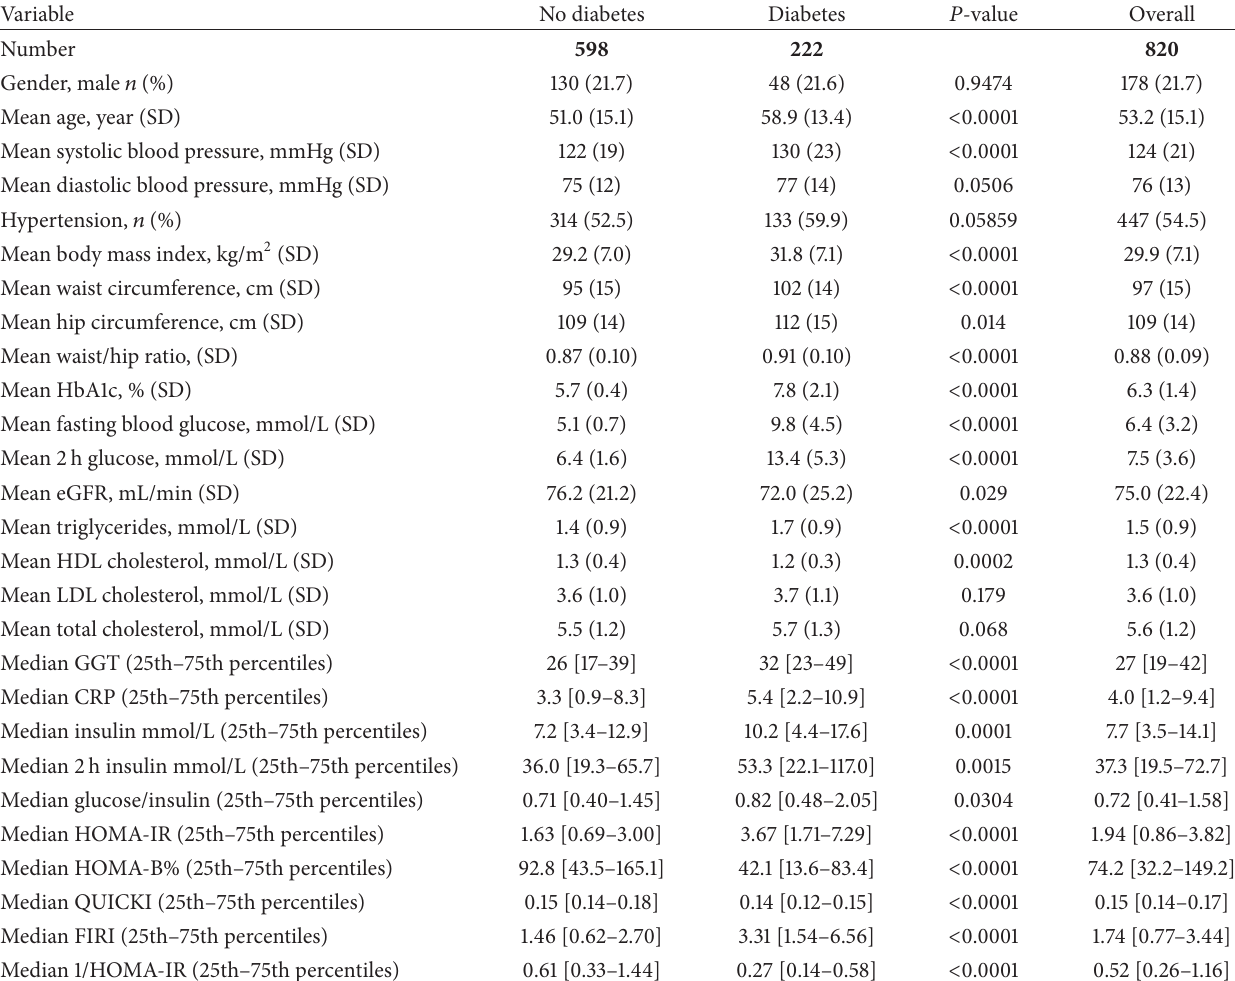
Table 1: General characteristics of the overall population and by diabetic